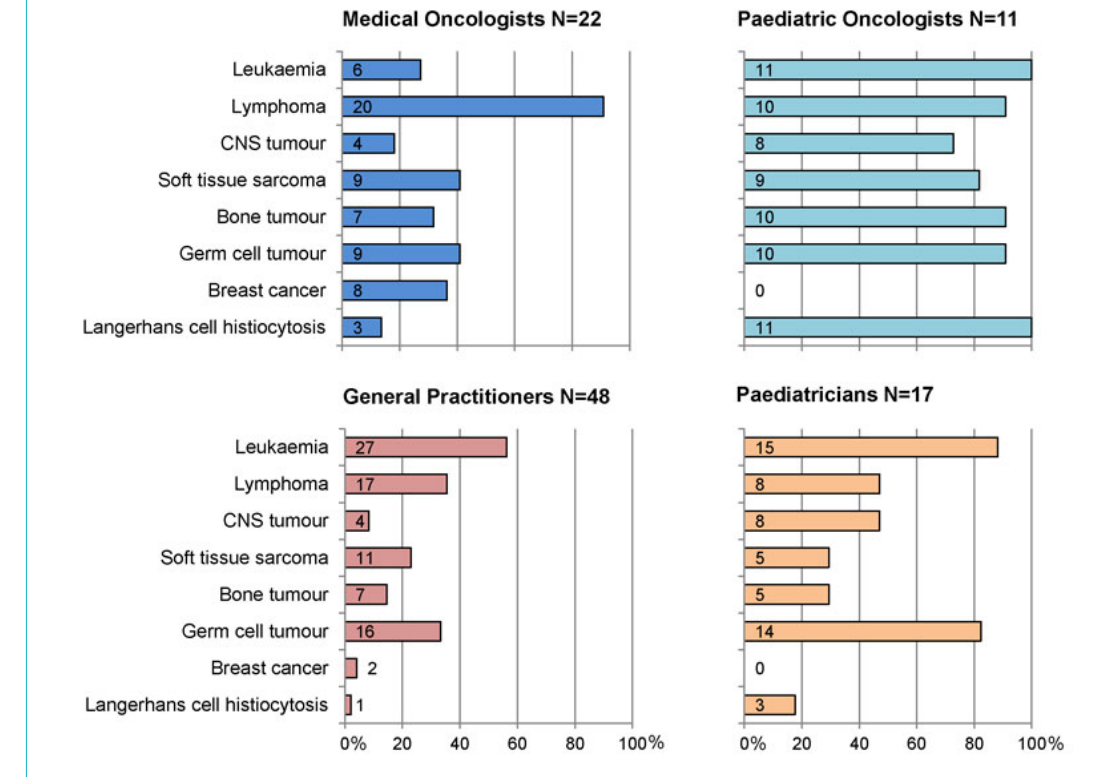
Figure 1: Types of cancer in follow-up care of different medical specialists.The values in the figure bars and values in the bars represent the number of physicians (N) who provide follow-up care to persons who suffered from each type of cancer, stratified by medical specialisation. The p-values from chi-square statistics for each type of cancer, comparing the four medical specialists, were p <0.001 for leukaemias, lym- phomas, central nervous system (CNS) tumours, bone tumours, germ cell tumours, breast cancers, Langerhans cell histiocytosis, and p = 0.002 for soft tissue